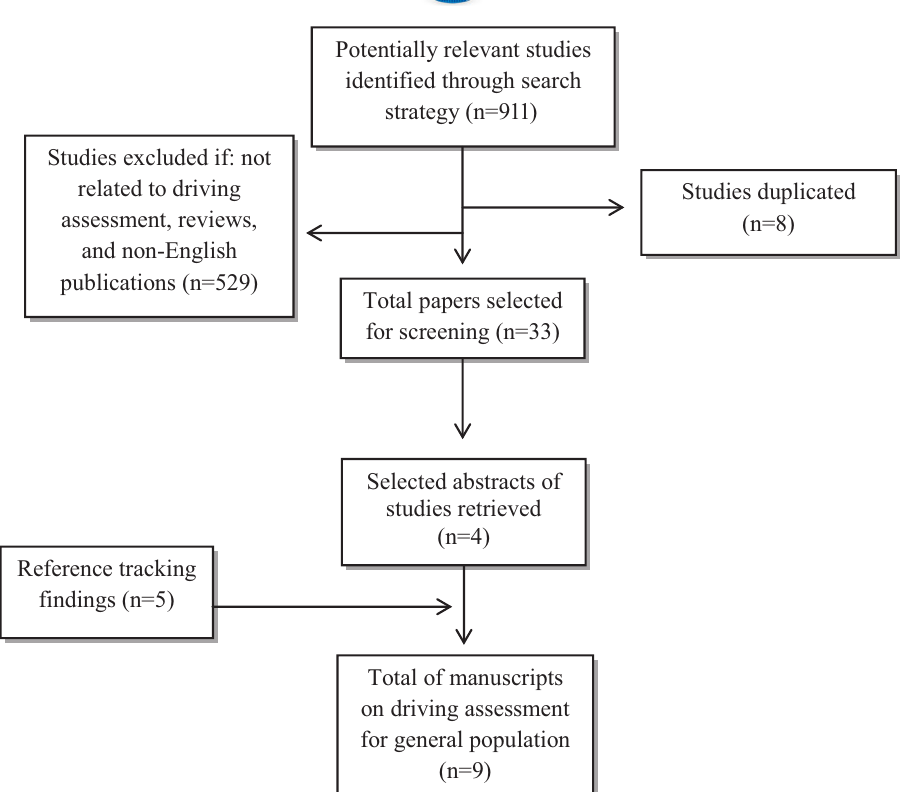
Figure 2 - Flowchart displaying screening process and search results of driving assessment for general